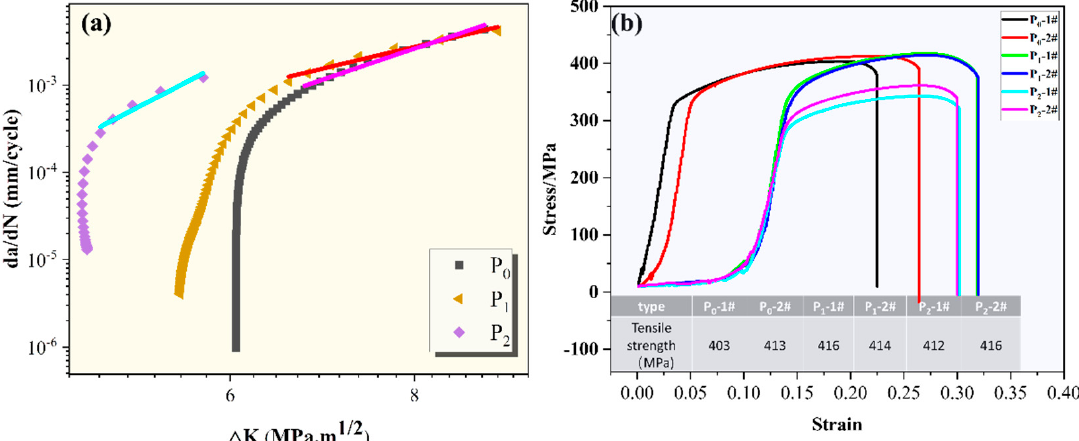
Table 3. Electrochemical impedance parameters.